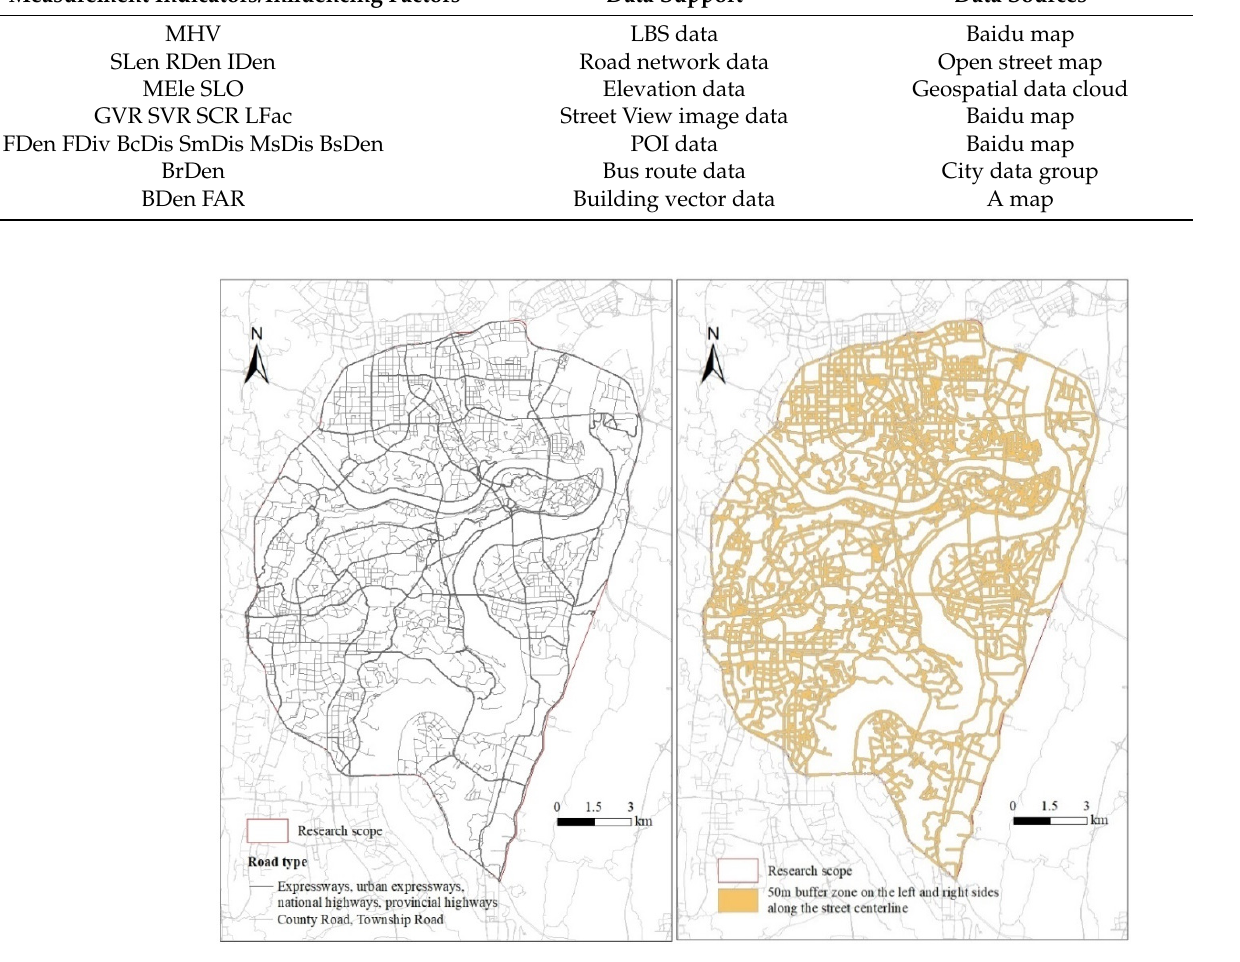
Figure 4. Results of image semantic segmentation.